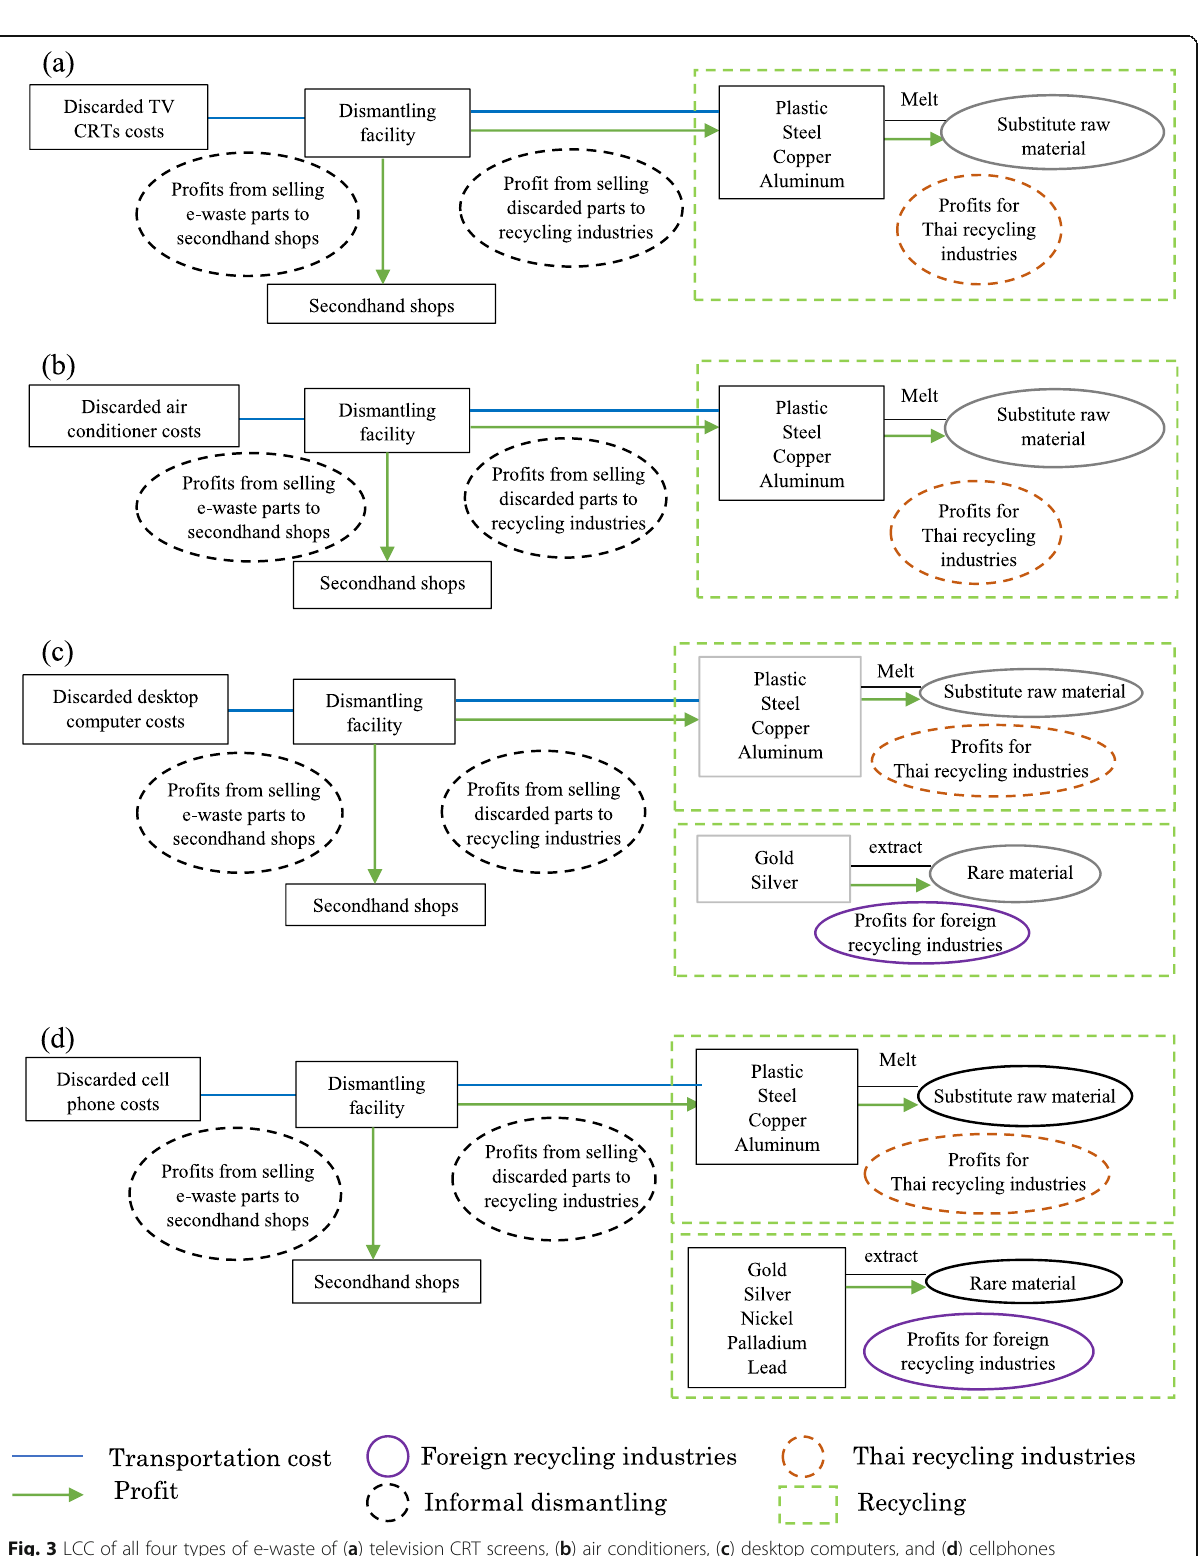
Fig. 3 LCC of all four types of e-waste of ( a ) television CRT screens, ( b ) air conditioners, ( c ) desktop computers, and ( d )